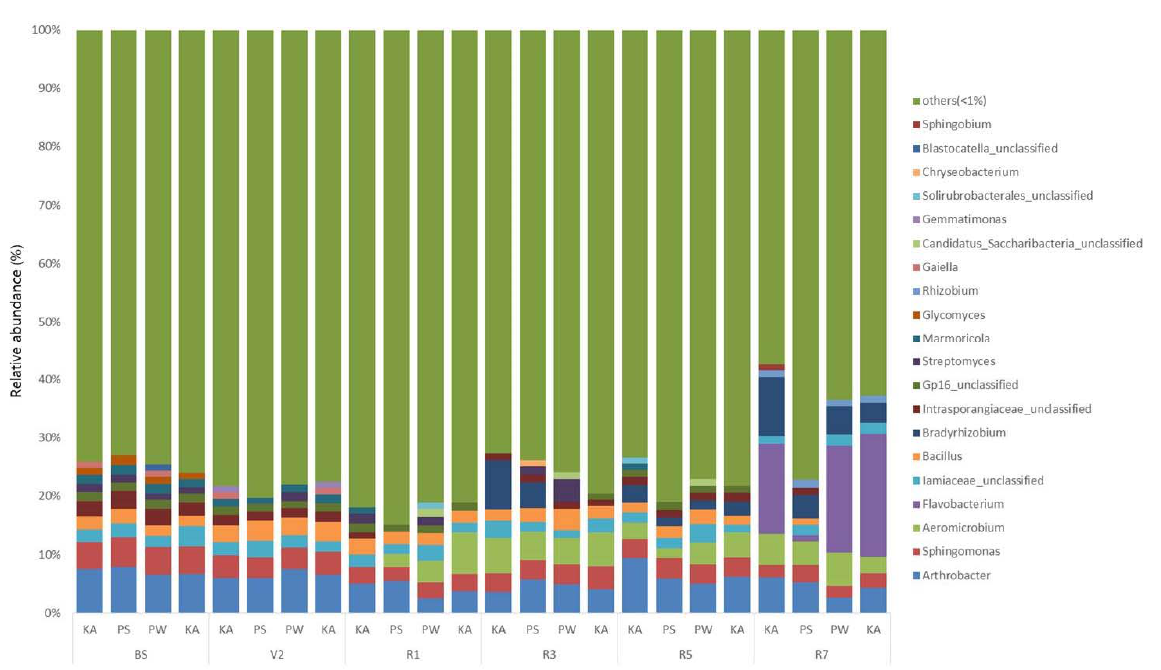
Figure 5. Relative abundance of genus in rhizosphere based on the variety and growth stages (V2, R1, R3, R5, R7) of soybean. KA, Kwangan; PS, Poongsannamul; PW, Poongwon; TK, Taekwang. Each bar represents the average relative abundance of triplicates.